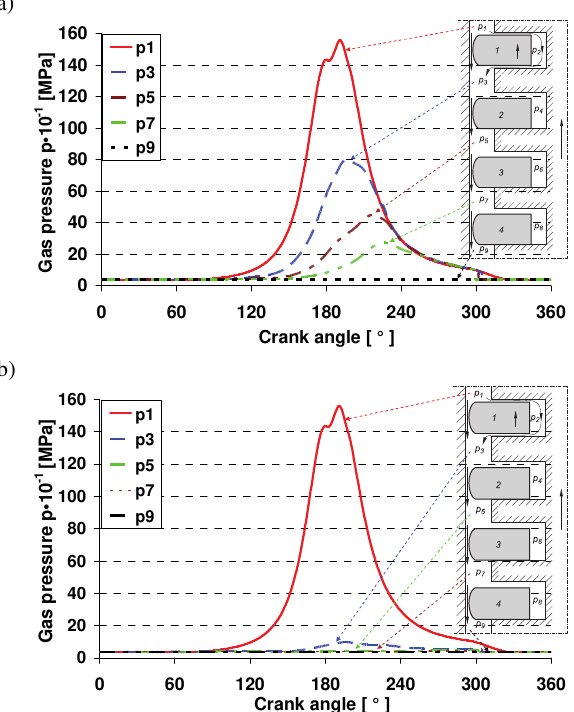
Fig. 5. Calculated gas pressure variations p i in all the volume regions versus crank angle. Gas pressure nomenclature: p 1 – in combustion